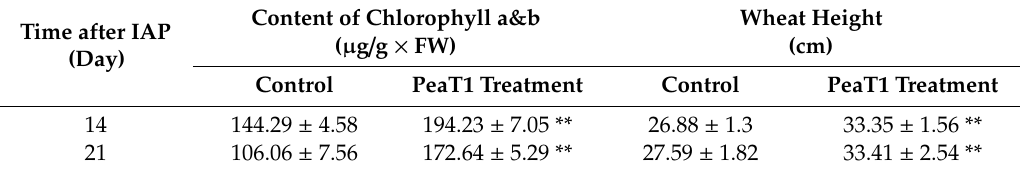
Figure 2. PeaT1 alleviated symptoms of dwarfism and yellow leaves in wheat caused by BYDV. Table 4. Content of chlorophyll and wheat height in control and PeaT1-treated wheat seedlings. Time after IAP (Day) Content of Chlorophyll a&b Wheat Height ( μ g/g × FW) (cm) Control PeaT1 Treatment Control